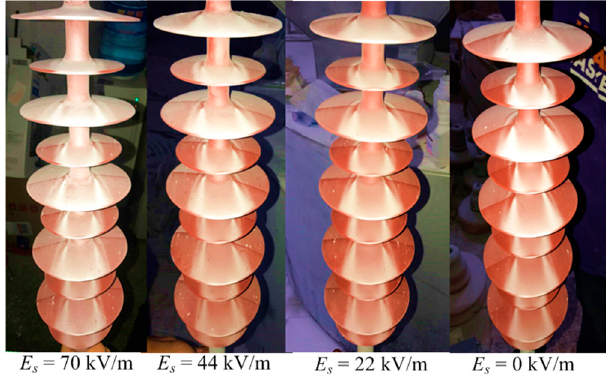
Figure 4. Contamination degree of short samples.